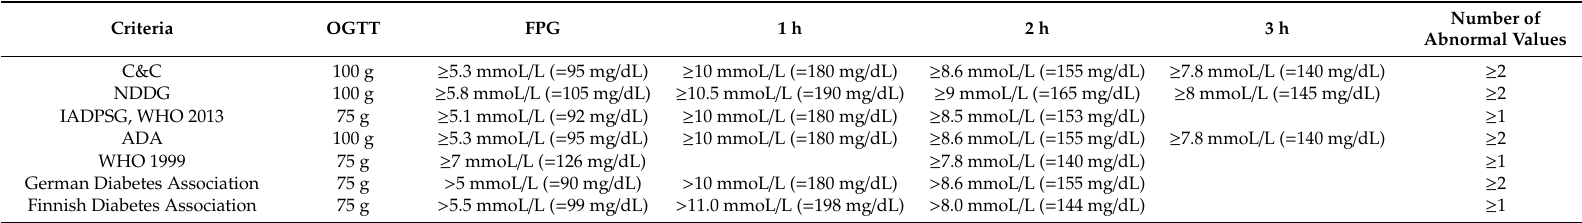
Table A1. This list gives an overview of the most commonly used gestational diabetes mellitus diagnosis criteria.